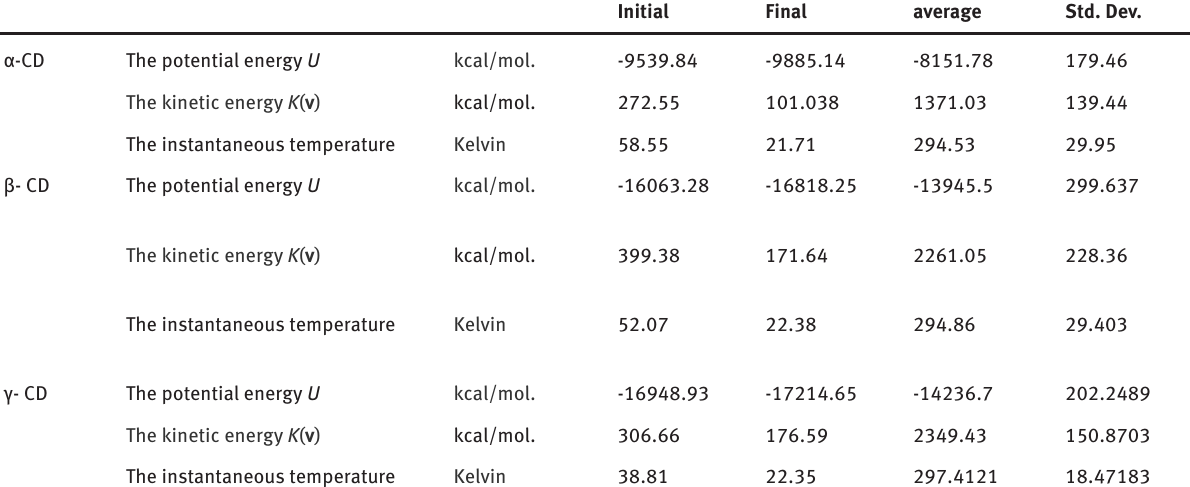
Table 6: Motion dynamics data